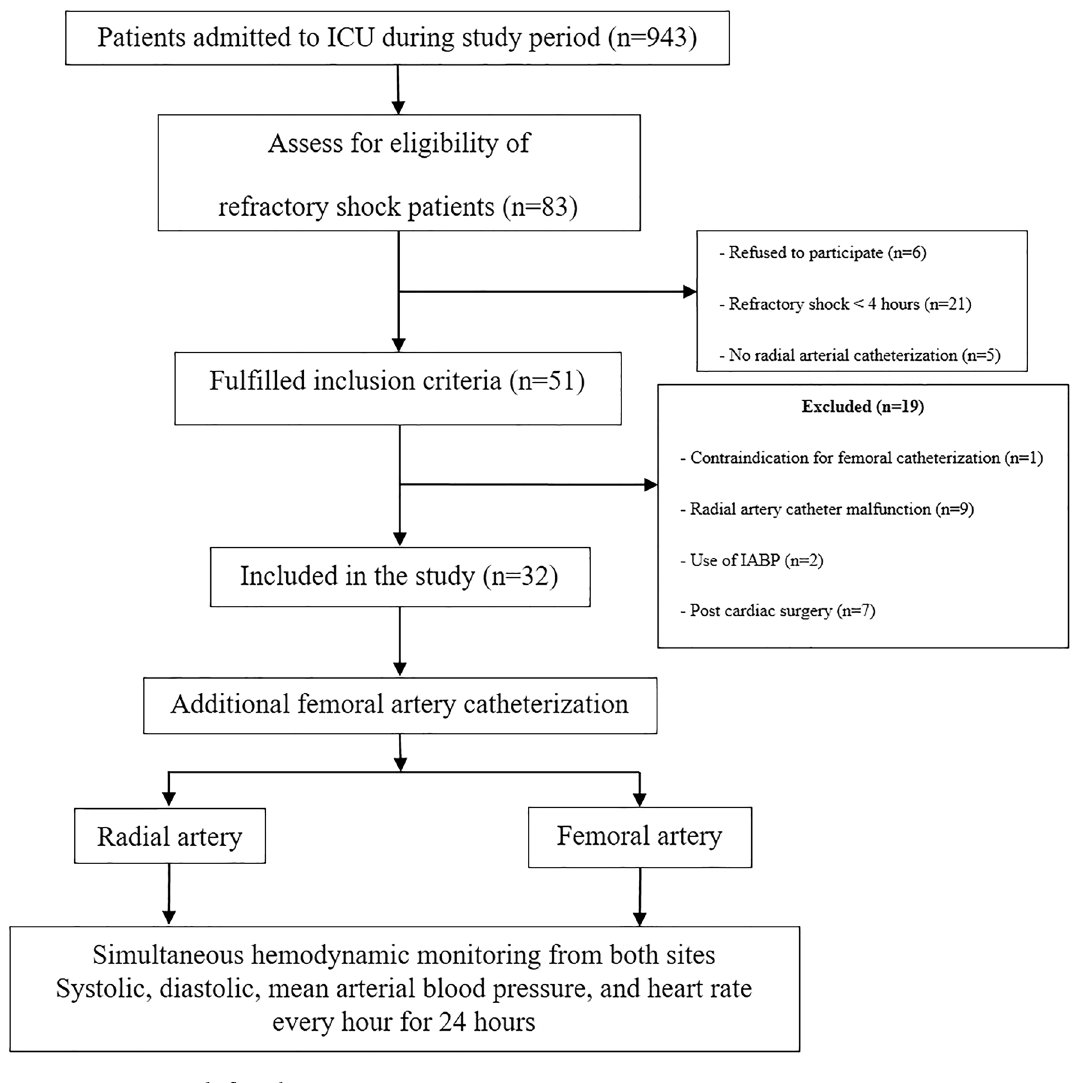
Figure 1. Study flow